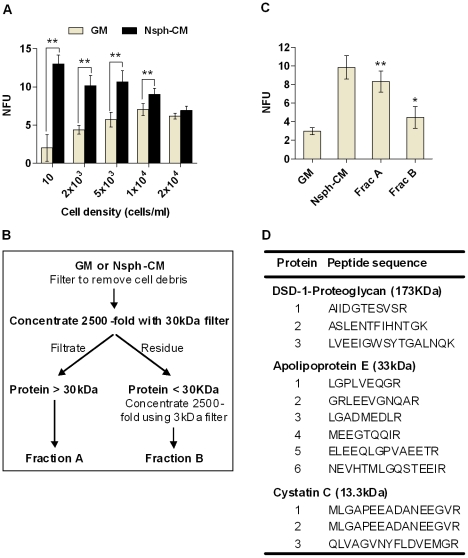
Identification of CSPG, ApoE and Cystatin C in nsph-CM.(A) Cells were plated at different densities (between 10 cells/ml to 2×104 cells/ml) in growth medium (GM) or neurosphere-conditioned medium (nsph-CM) and nsph forming units (NFUs) measured after five days of culture. NFU is the number of nsph formed divided by number of cells seeded x 100. The cell density of 10 cells/ml represents 1 cell per well. The data are presented as the mean ± SEM with n≥6 (from 3 experiments), **P≤0.01 compared to GM at each concentration. (B) After removal of cell debris and whole cells, nsph-CM was concentrated 2500-fold and size fractionated into two parts; proteins >30 kDa (fraction A) and <30 kDa (fraction B). Fraction B was further concentrated 2500-fold as described in the Materials and Methods section. (C) Cells were plated at 2×103 cells/ml in GM, nsph-CM, fraction A or fraction B. Nsph-CM, fractions A and B were reconstituted into GM to the original concentration prior to cell culture. Data are presented as mean ± SEM with n≥6 (from 3 experiments); *P≤0.05, **P≤0.01 compared to GM. (D) Fractions A and B derived from GM and nsph-CM were digested with trypsin and the mass of peptides evaluated using liquid chromatography-mass spectrometry (LCMS). The table shows peptide sequences unique to nsph-CM leading to the identification of DSD-proteoglycan, apolipoprotein E and cystatin C.